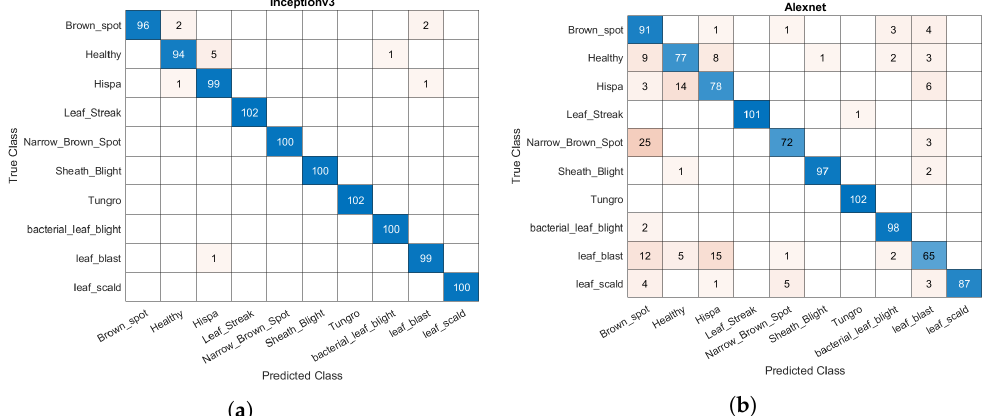
Figure 6. Confusion matrices for the finest and the poor performing pre-trained models using 90% of the training data. ( a ) InceptionV3; ( b ) AlexNet. Table 9. The mean overall performance metric values using using 90% of the training data.